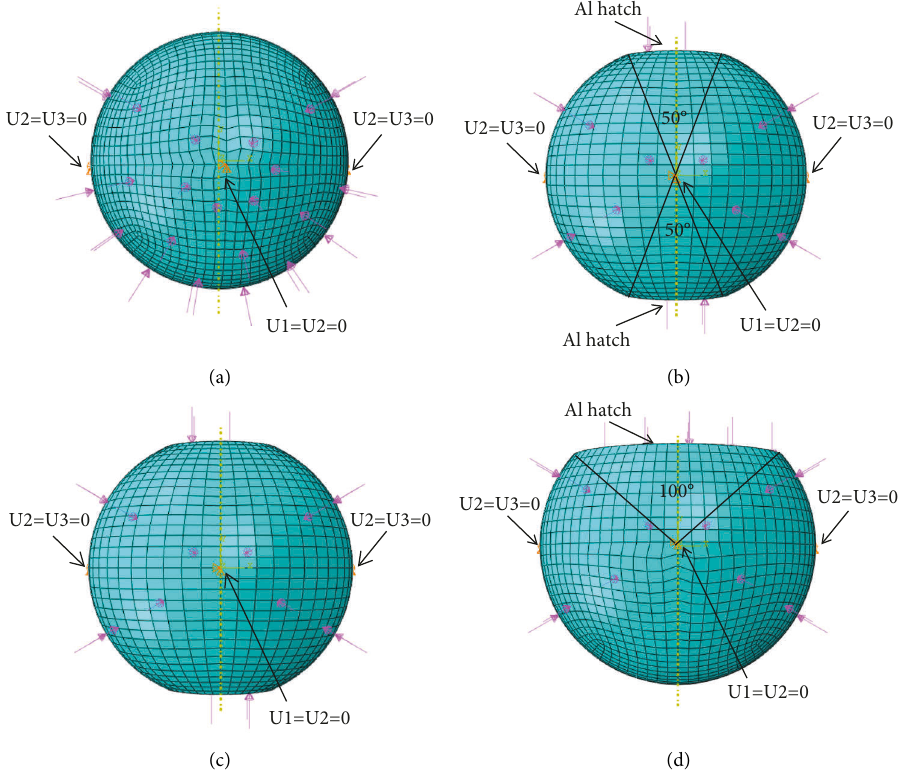
Figure 1: Penetration and boundary conditions of PM MA spherical hull model: (a) complete shell, (b) single penetration, (c) double penetration, and (d) hyperspherical